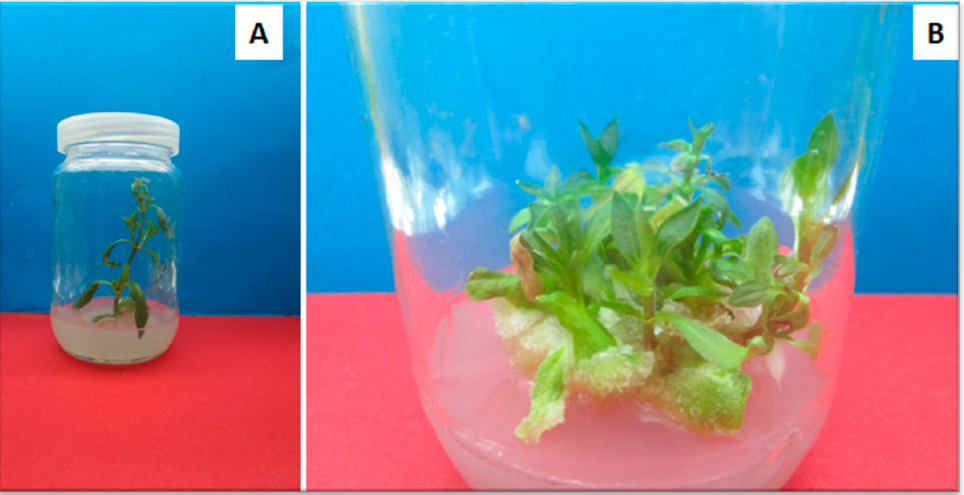
Figure 9. Effect of basal callus on in vitro shoot proliferation of Jerusalem artichoke plant ( Helianthus tuberosus L.). Photo ( A ) = normal shootlet, whereas photo ( B ) = shootlets with base callus.